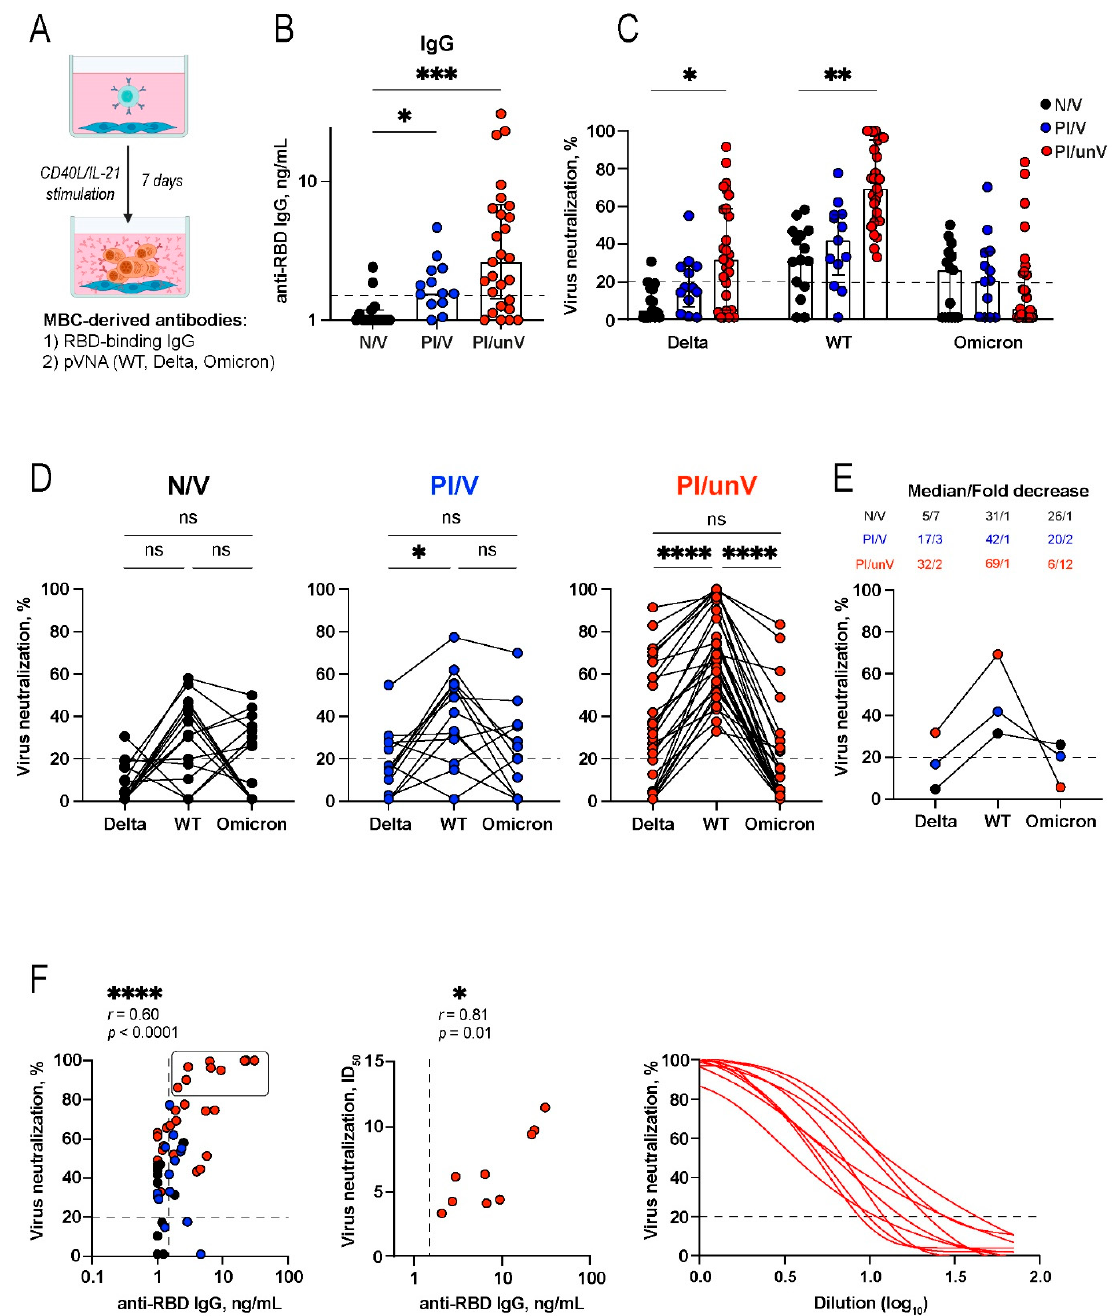
Figure 3. Analysis of MBC-derived antibody response of in vitro reactivated memory B-cells elicited by natural SARS-CoV-2 infection and by Gam-COVID-Vac vaccination. ( A ) Schematic representation of the MBC-derived antibody assay. ( B ) Production of RBD-specific IgG in cultures of IL-21/CD40L-stimulated B-cells evaluated using ELISA. ( C ) Virus-neutralizing activity of MBC-derived antibodies against WT strain and Delta and Omicron variants in different study groups. Infected (% GFP + ) cells relative to no antibody controls. ( D ) Comparison of neutralization activity of individual supernatant samples against WT-, Delta-, and Omicron-pseudotyped lentiviral particles. Symbols connected by solid lines represent virus-neutralizing activities considered for each individual. ( E ) Summary of virus-neutralizing activities of MBC-derived antibodies against WT strain and Delta and Omicron variants. ( F ) Spearman’s correlation between the levels of anti-RBD IgG and % of WT virus neutralization (left panel) or ID 50 (middle panel). Nine most active supernatants on the left panel are marked with a rectangle. Nonlinear regression curves for virus neutralization of the nine most active